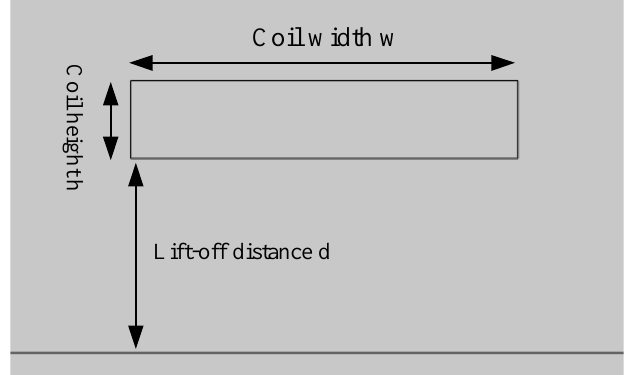
Figure 17. The resultant displacement of surface wave.